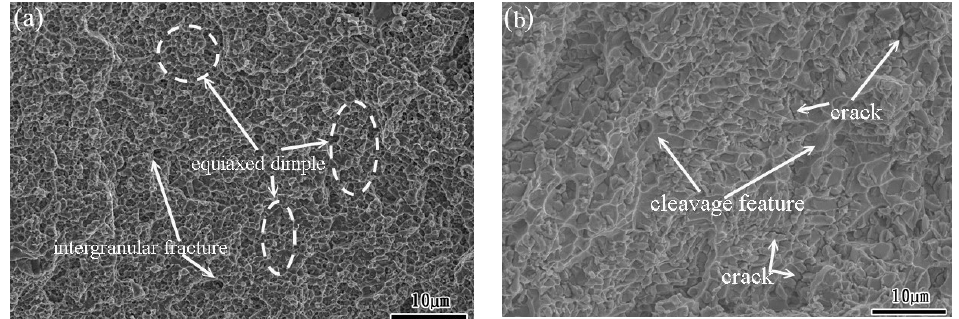
Figure 12. Fracture surface morphology of TiNi 44 Nb 6 alloy under ( a ) static deformation conditions, and ( b ) dynamic deformation conditions (2000× magnification).